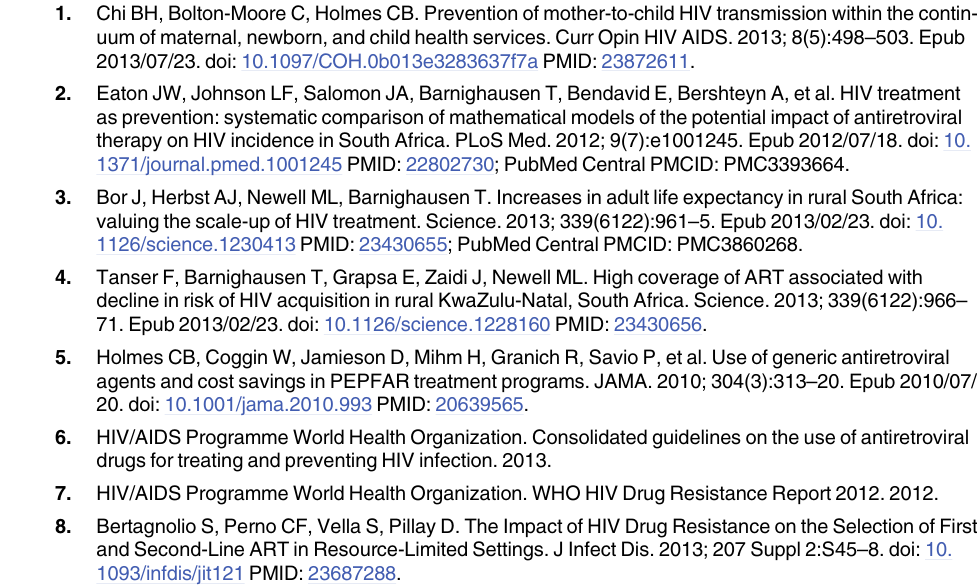
S8 Table. Proportion of Different Codons at Position 103 in HIV-1 RT Sequences from 26,358 Individuals in the Stanford HIV Drug Resistance Database From Six Low- and Mid- dle-Income Country Regions. S9 Table. Proportion of Different 24 Nucleotide Sequences Flanking Position 103 in HIV-1 RT Sequences from 26,358 Individuals in the Stanford HIV Drug Resistance Database From Six Low- and Middle-Income Country